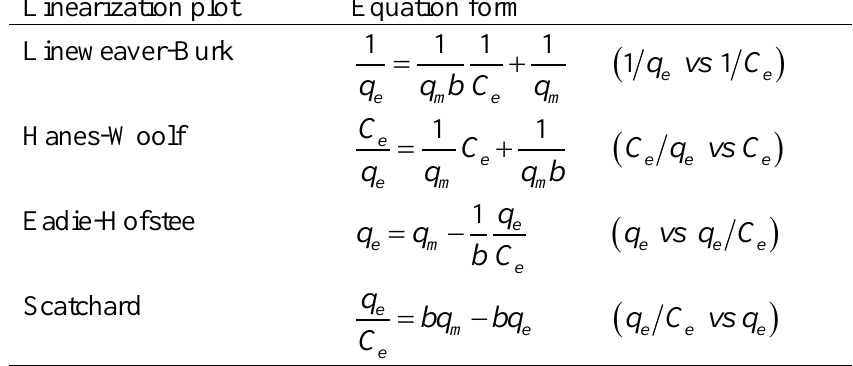
Figure 2. Equilibrium data in Figure 1 fitted with the following linearizations: